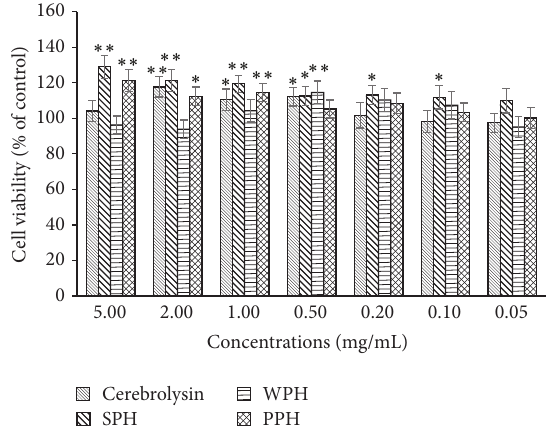
Figure 3: Promoting effect of different hydrolysates in cultured PC12 cells. Each value indicates a mean ± SD ( 𝑛 = 3 ). ∗ 𝑝 < 0.05 and ∗∗ 𝑝 < 0.01 , compared with control